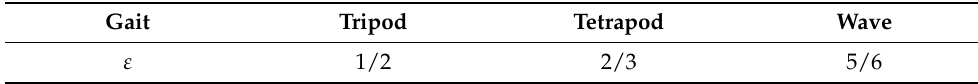
Table 1. Common gaits corresponding to the coverage